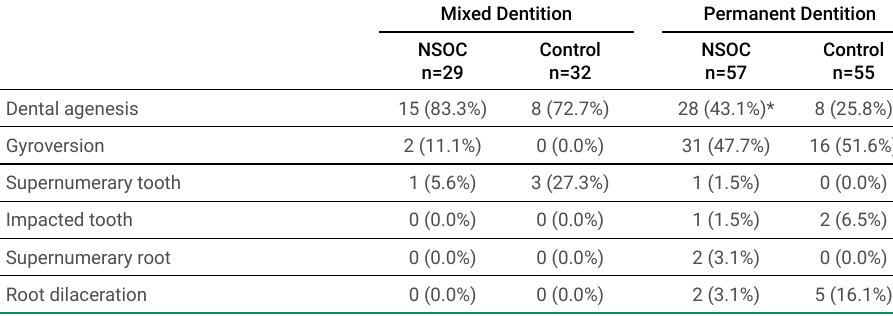
Table 2. Distribution of dental anomalies in the mixed and permanent dentitions in the nonsyndromic oral cleft and control groups.